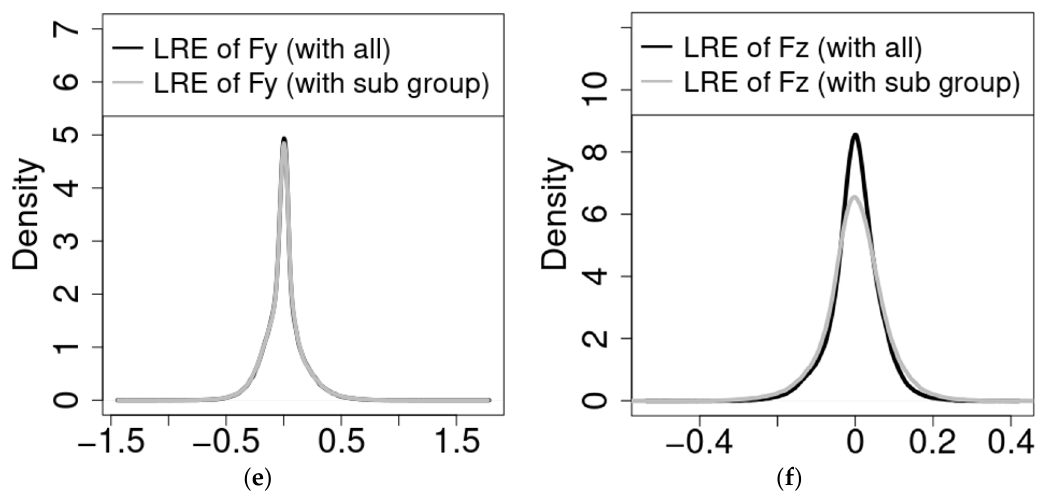
Figure 7. Load relative error [9] distributions for estimated transmission input moments with all predictors (black) and with only the highly important subset of predictors (grey). The panels show the LRE for each of the respective target variables listed in Table 1 ( a – f ), covering variables v1–v6, respectively.